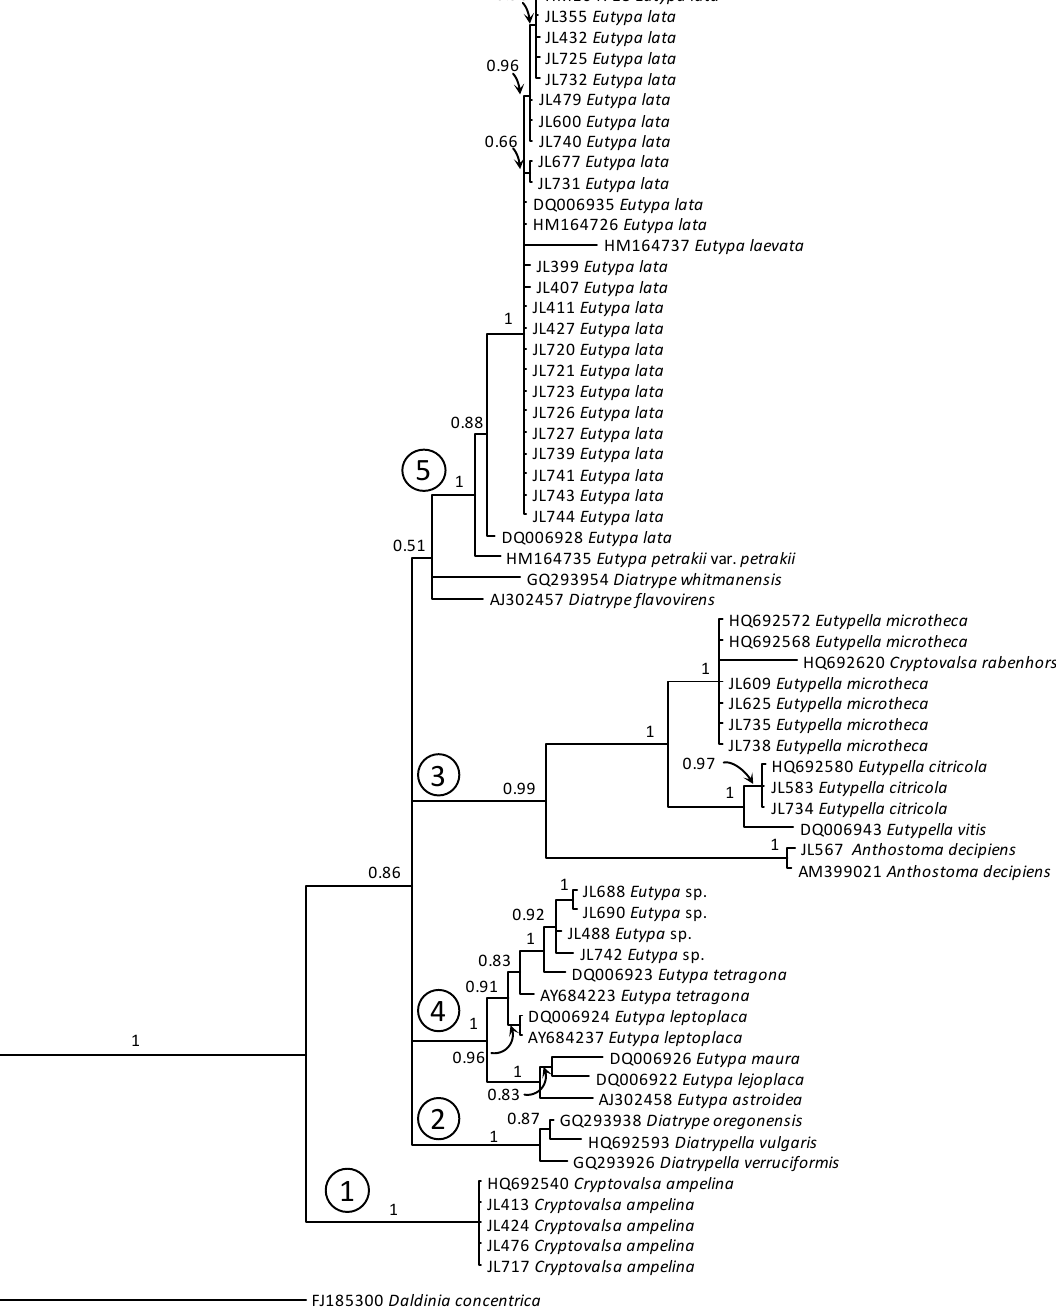
Figure 1. Majority rule consensus tree resulting from the Bayesian analysis of the ITS sequence data, with posterior prob- abilities reported at the nodes. Sequences obtained from GenBank are indicated by their accession numbers while iso- lates obtained in this study are indicated by their code numbers. Clades are numbered in circles. Bars represent expected changes per